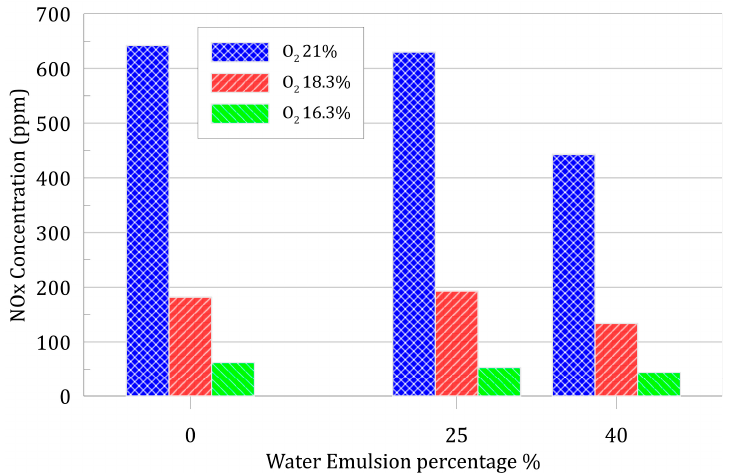
Figure 17. NOx emissions concentration in the case of EGR–WFE combination.